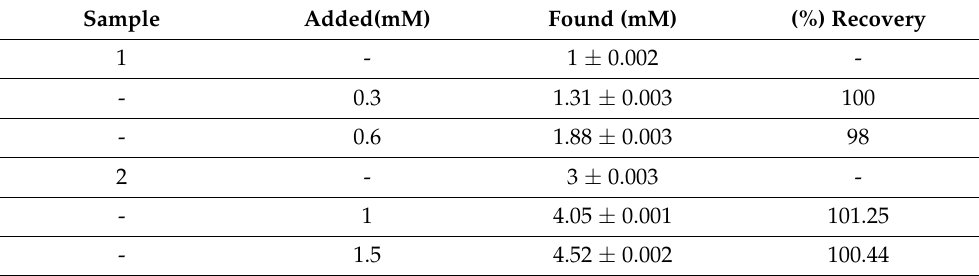
Table 5. Blood serum sample analysis using % recovery method for the detection of urea.